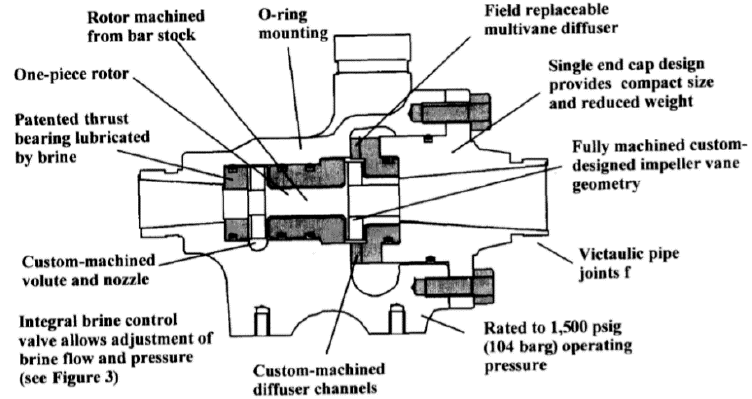
Figure 18. The internal construction and features of the HPB TM [ Error! Reference source not found. ].